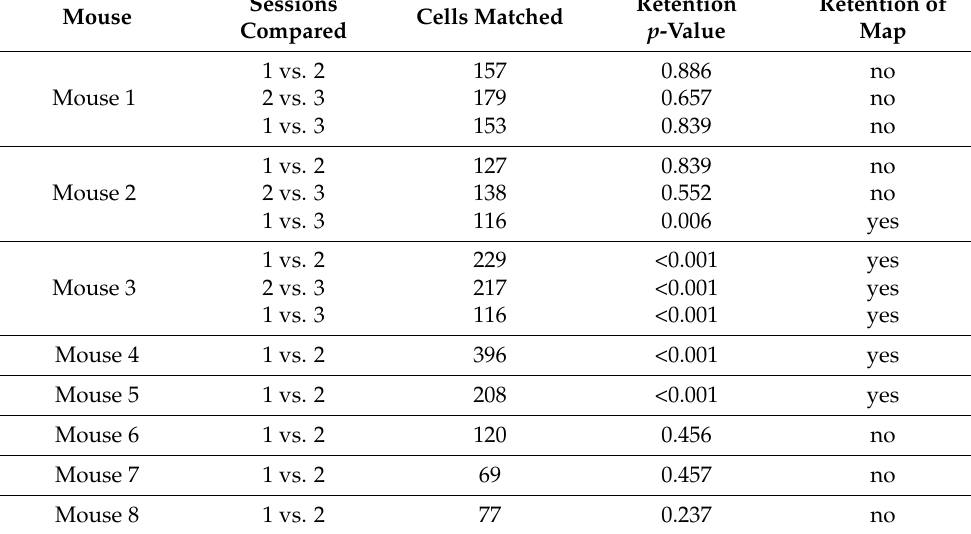
Table A2. Cell matching and remapping rate statistics between sessions. We considered that the cognitive map retained between sessions in case of the significant similarity of the distribution of